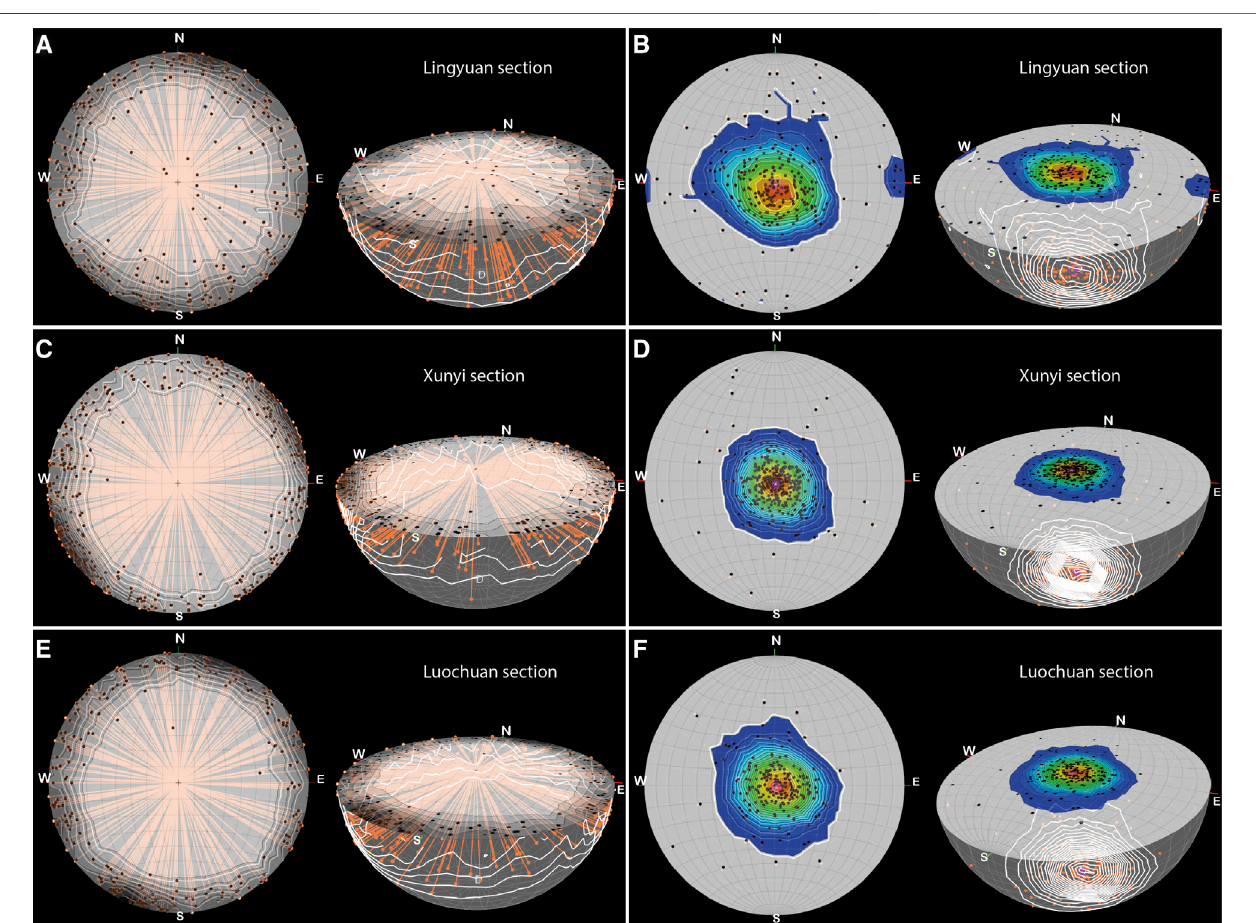
FIGURE 3 | (A,C,E) 3D stereographic projections of K max (black dots) displaying the stereonet as the top of a bowl, the bowl as a transparent half-sphere in addition, horizon contour features are shown. Orange dots and lines represent K max projected in the bowl. (B,D,F) 3D stereographic projection of K min (black dots) displayingthestereonetasthetopofabowl,thebowlasatransparenthalf-sphereinadditionhorizoncontourfeaturesareshown.Orangedotsandwhitelinesrepresent K min and contours projected in the bowl. The pink dots and circles represent mean K min orientation and its error.